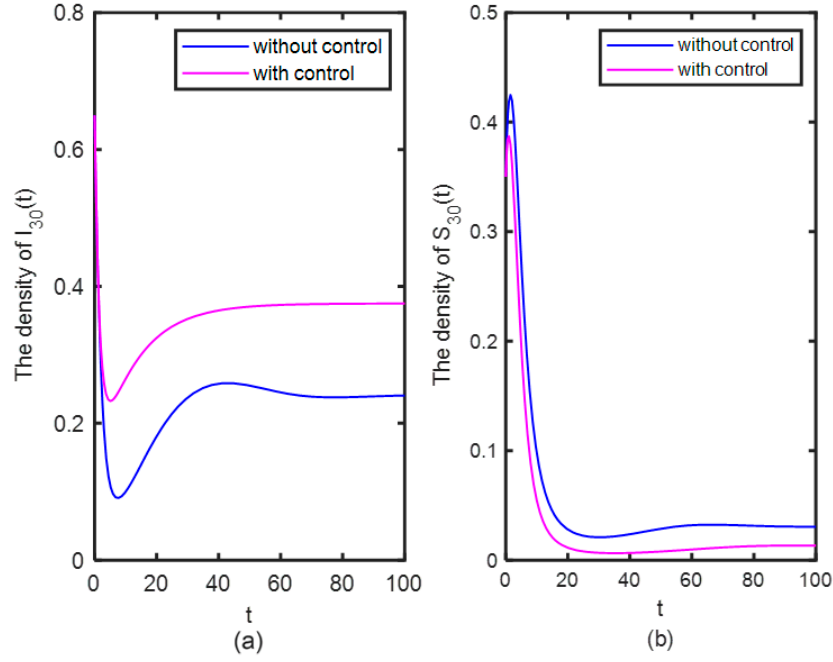
( ) ( ) (a), (b) I t S t with and without the optimal control. Figure 9. The densities of I 30 ( t ) ( a ), S 30 ( t ) ( b ) with and without the optimal 30 30